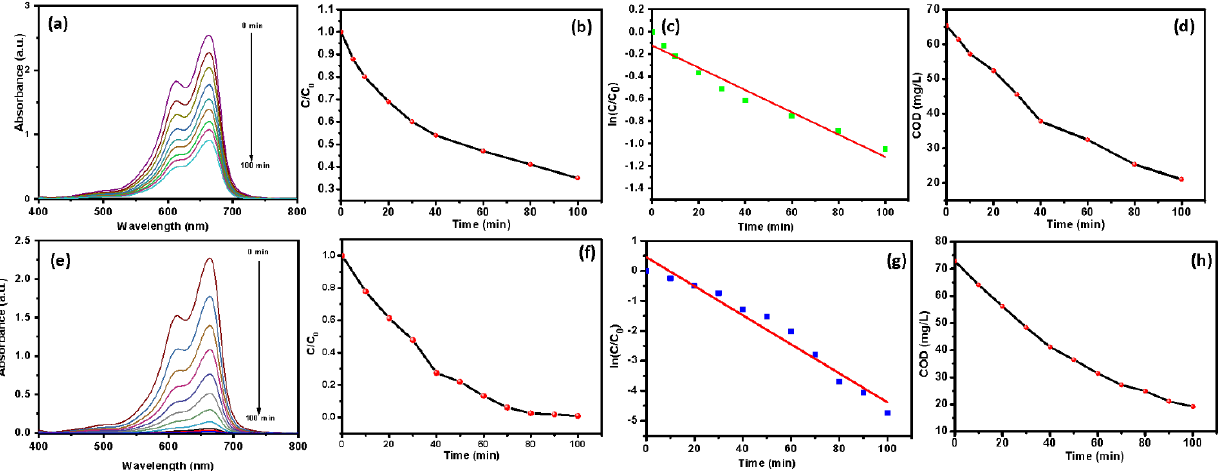
Figure 7. Photocatalytic degradation of MB using V 2 O 5 , ( a ) extinction spectra, ( b ) C/C 0 vs. time, ( c ) ln(C/C 0 ) vs. time and ( d ) the variation in COD values with respect to time, and photocatalytic degradation of MB using V 2 O 5 /RGO composite, ( e ) extinction spectra, ( f ) C/C 0 vs. time, ( g ) ln(C/C 0 ) vs. time and ( h ) the variation in COD values with respect to time.